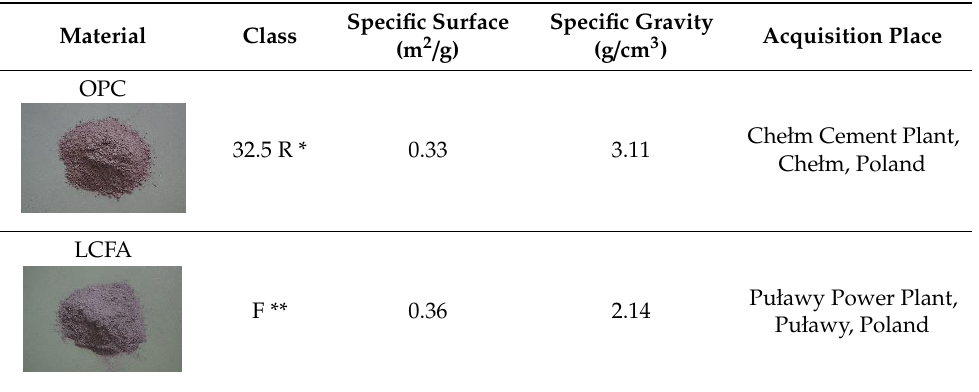
Table 2. Properties of binders used in this study.